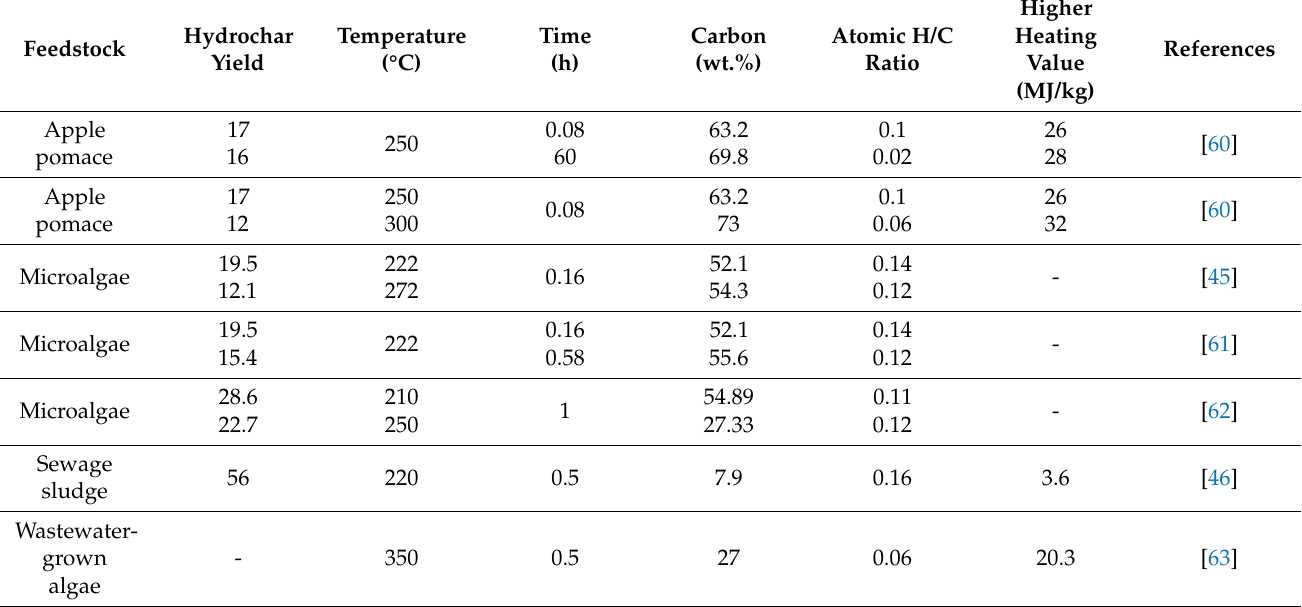
Table 3. Hydrothermal liquefaction process to produce hydrochar from different feedstocks.